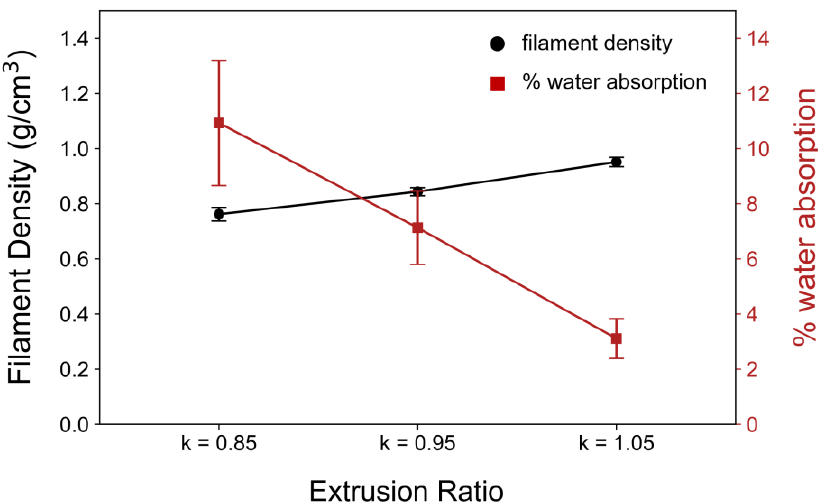
Figure 4. Filament density and % water absorption of 3D-printed specimen fabricated with 0.40 mm layer height and different extrusion ratios ( k = 0.85, 0.95, and 1.05). For each case, five printed specimens were evaluated. Data are plotted as the mean ± s.d.